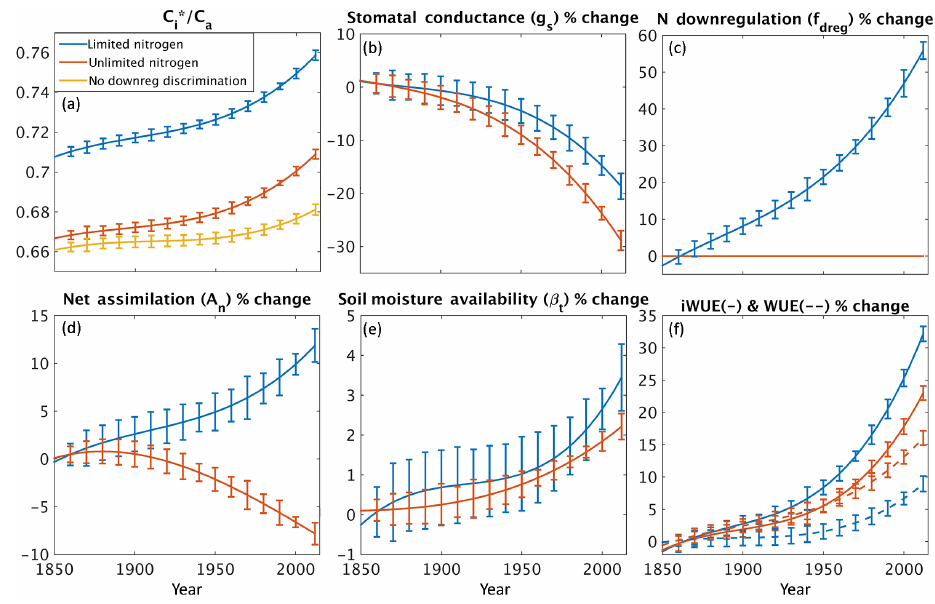
Figure 7. Diagnostic model variables that explain the discrimination trends (Fig. 5) for the three model formulations as described in Table 2 /c a , (b) g s , (c) f dreg , (d) A n , (e) β t , and (f) the WUE and iWUE. Where the no-downregulation discrimination simulation is for (a) c ∗ i not shown, it was identical to the limited nitrogen simulation. Uncertainty bars represent 95% confidence intervals of diagnostic variable variation as a result of cycling the site-level meteorology observations. The dashed lines represent WUE and the solid lines represent iWUE in (f)